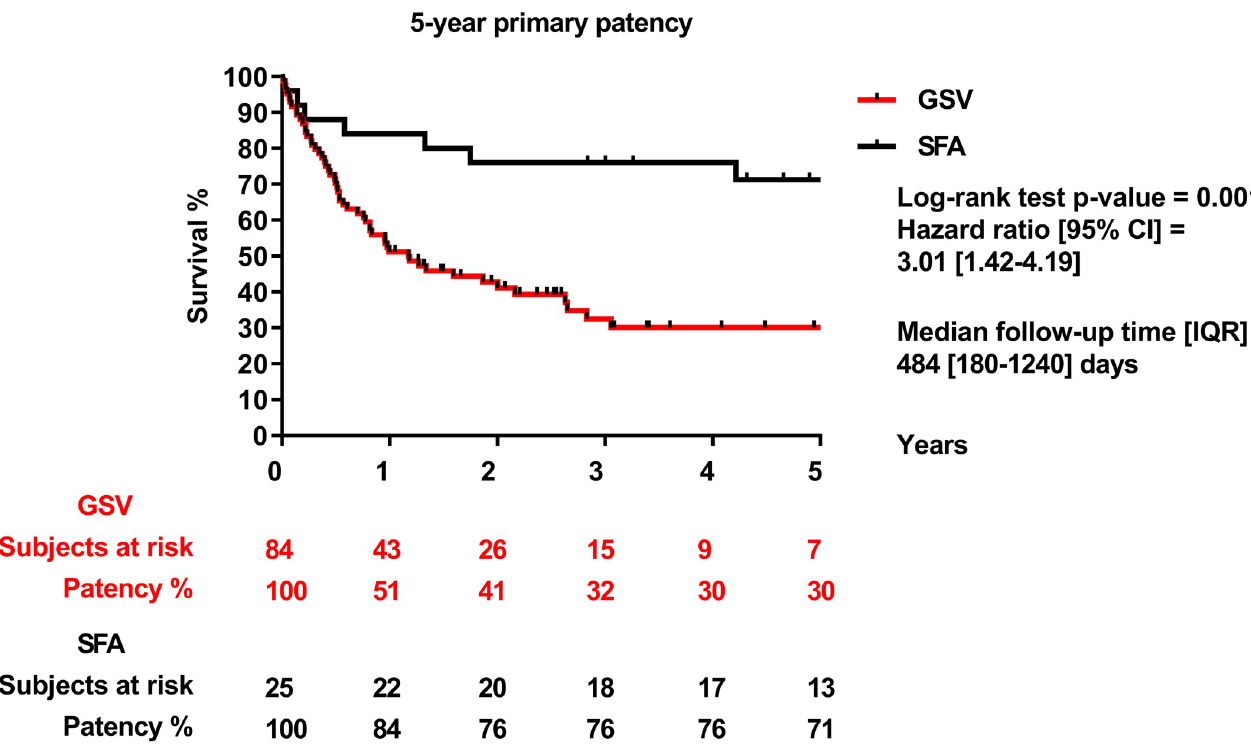
Fig 3. 5-year primary patency of GSV (great saphenous vein) and SFA (superficial femoral artery).